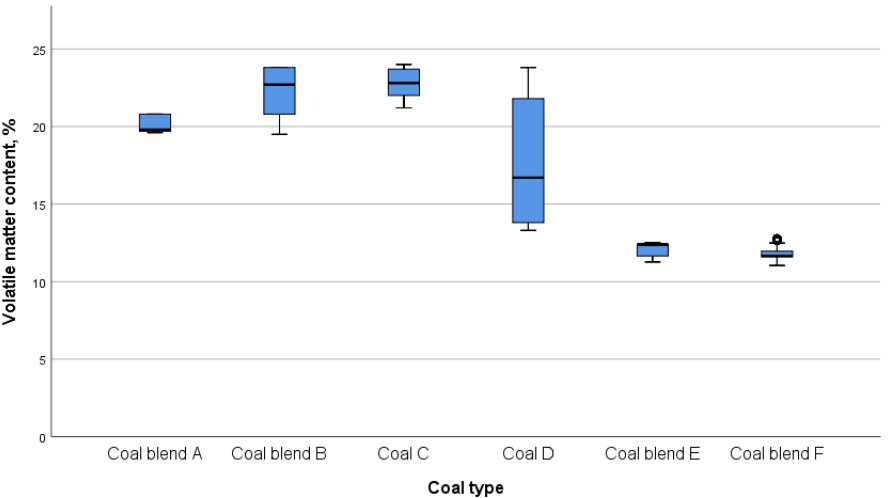
Figure 1. The range of the measured volatile matter contents for oven-dried coals and coal blends used during the study periods (◦ represents outliers) .